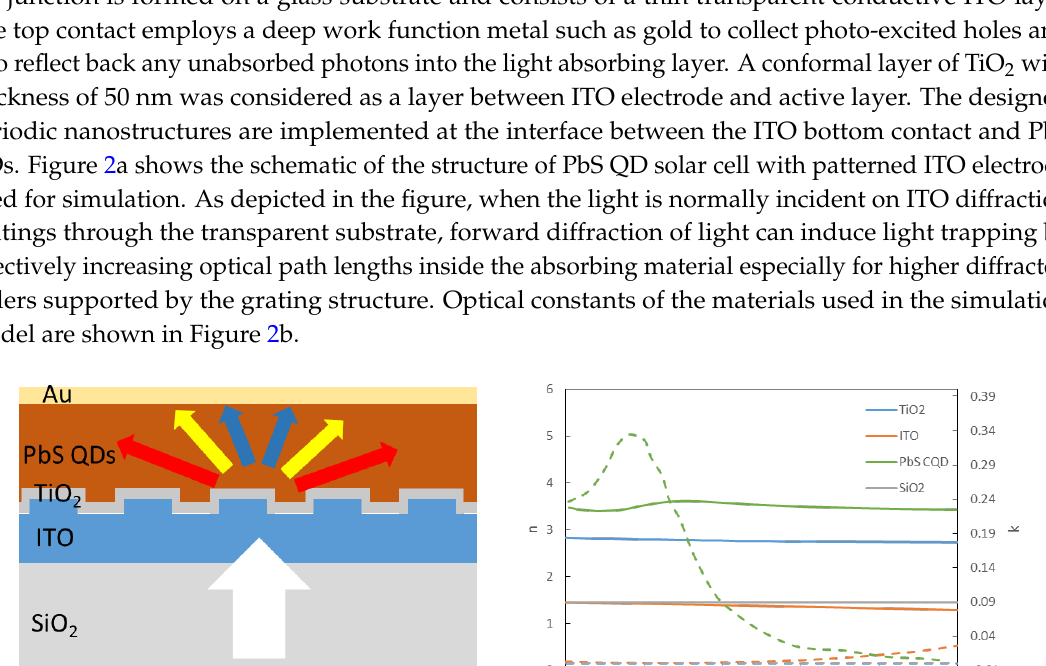
Figure 2. ( a ) Schematic of light diffraction in PbS quantum dot (QD) solar cell with patterned indium-doped tin oxide (ITO) electrode. ( b ) Optical constants of the materials used in the simulation model.